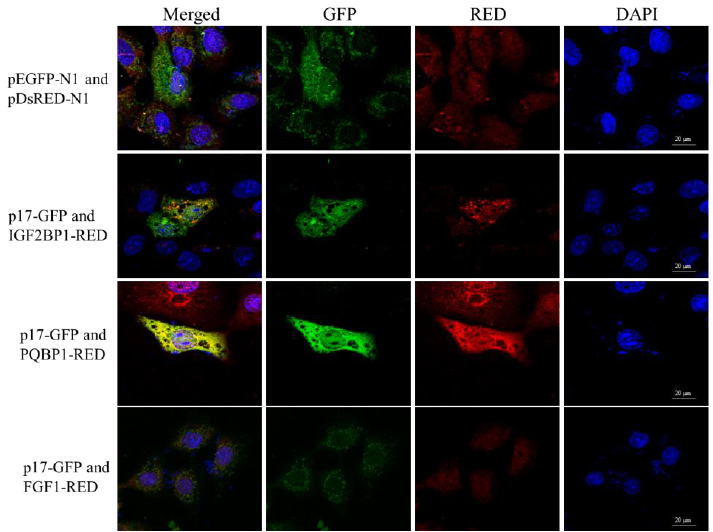
Figure 4. The colocalization of ARV p17 with the screened host proteins. Vero cells were cotransfected with p17-GFP and IGF2BP1, PQBP2 or FGF1-RED and then analyzed by laser confocal microscopy after 36 h. All cells were stained with Hoechst 33342.